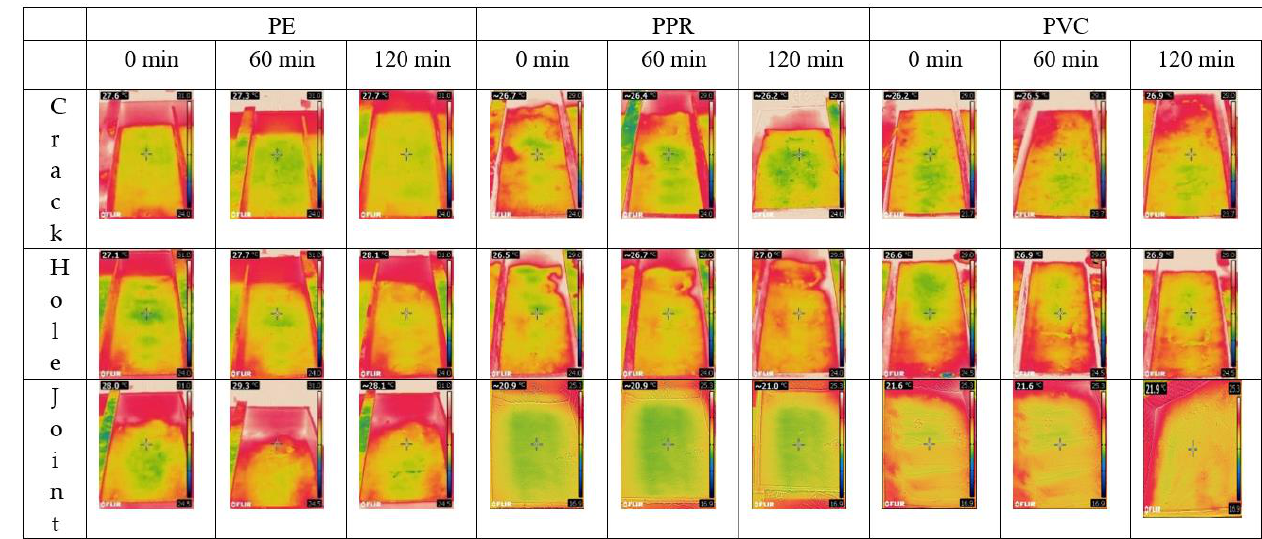
Figure 15. IR images obtained on PPR, PVC and PE setup with 10% soil moisture content.